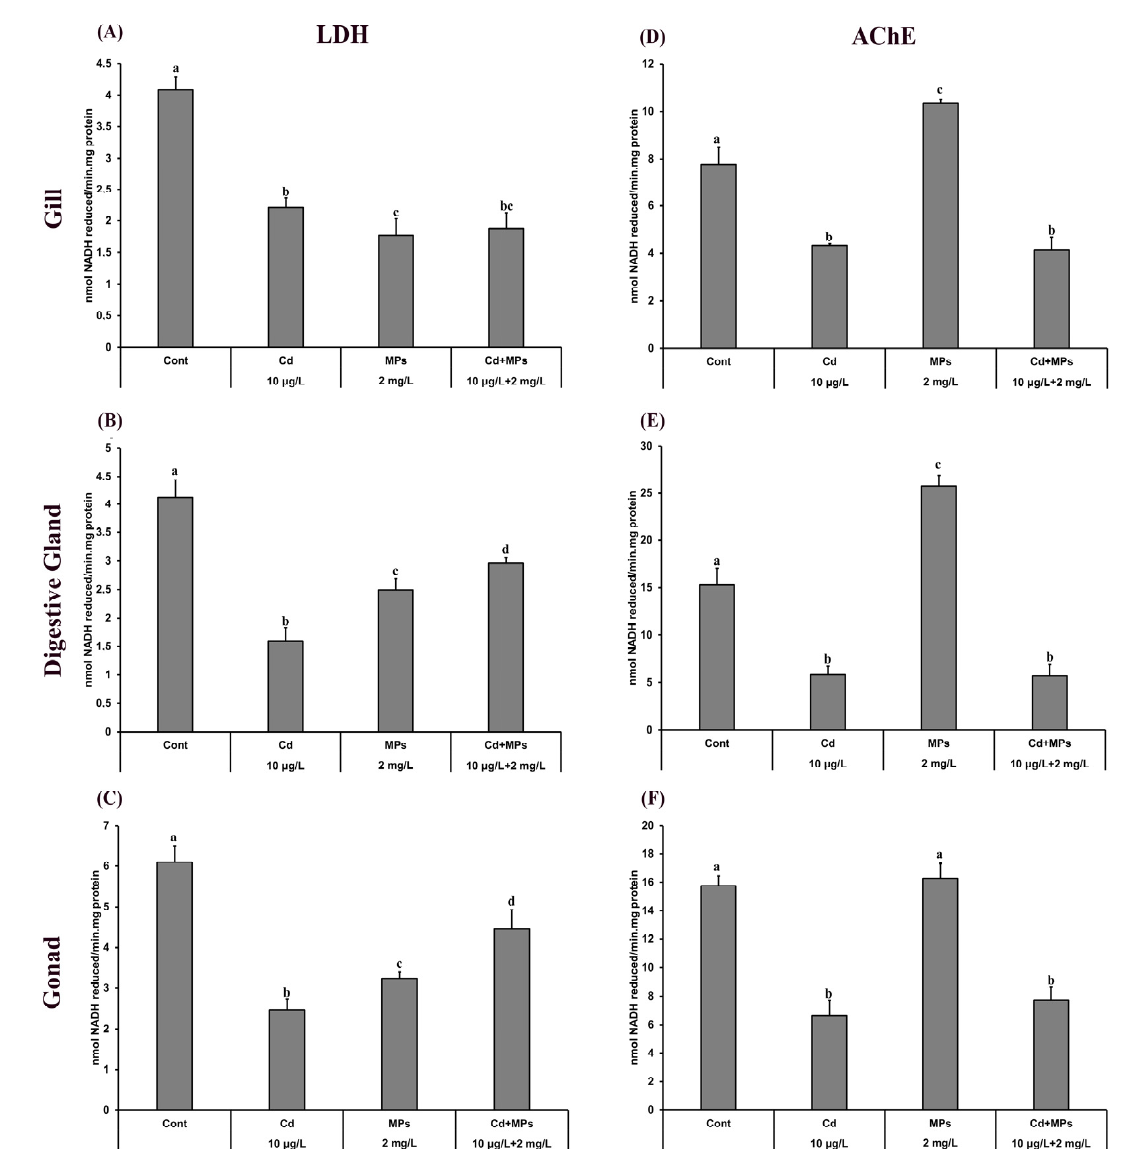
Figure 2. Lactate dehydrogenase (LDH) levels and acetylcholinesterase (AChE) activity determined in the gill ( A , D ), digestive gland ( B , E )or gonad ( C , F ) of Corbicula fluminea after exposure to cadmium (Cd) and/or microplastics (MPs) for 7 days. Data are expressed as mean ± SD from four experimental groups. Different lowercase letters indicate significant differences between groups ( p <